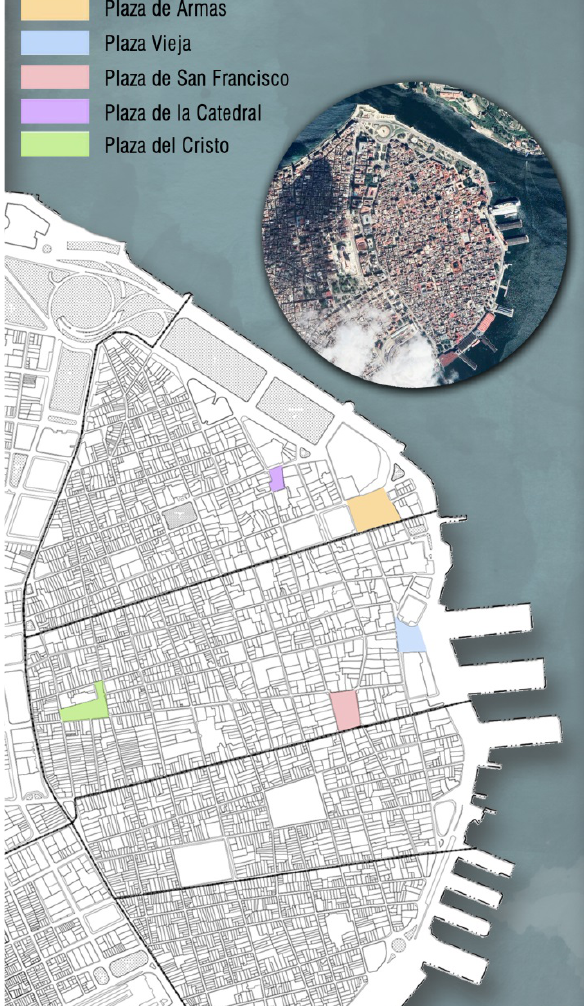
Figure 1. Havana's five main